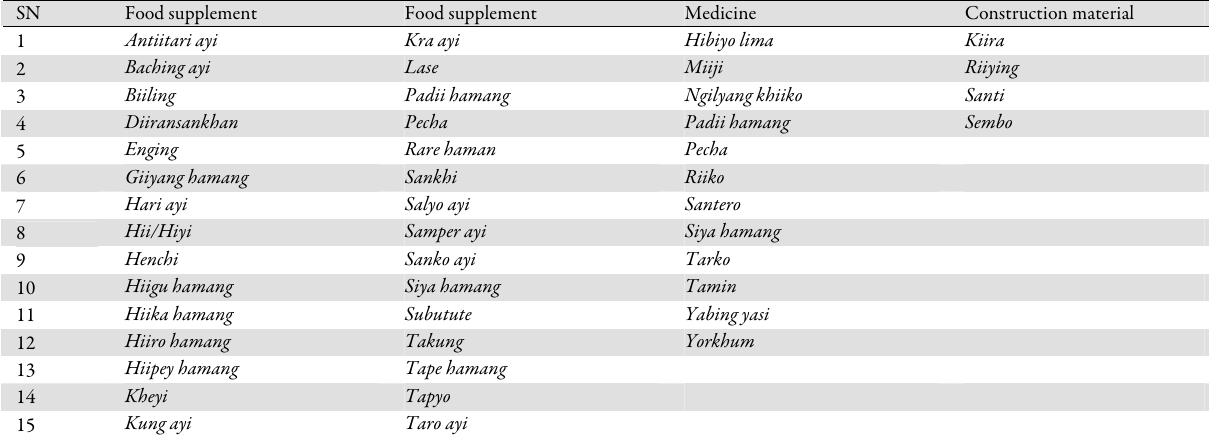
Table 2. List of NTFPs sold in the market as food supplement, medicine and construction material